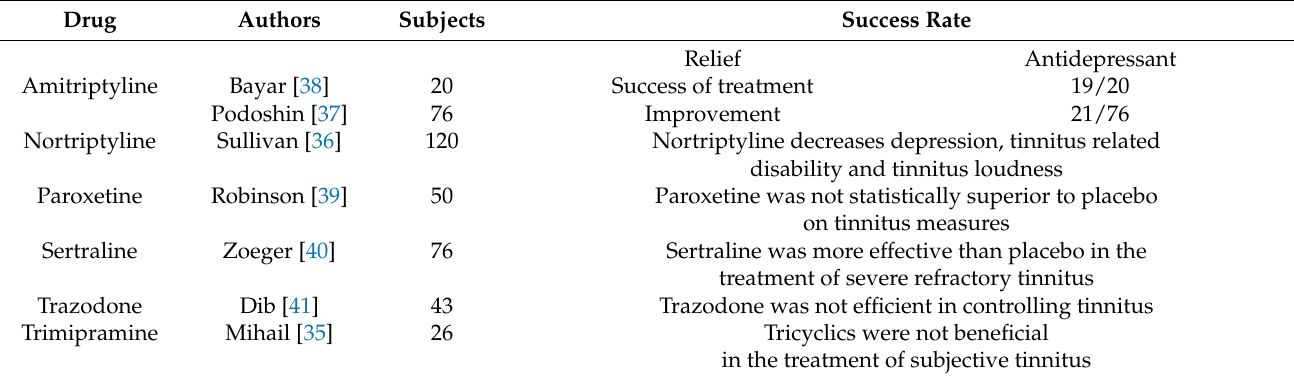
Table 6. Summary of studies that used antidepressants to treat